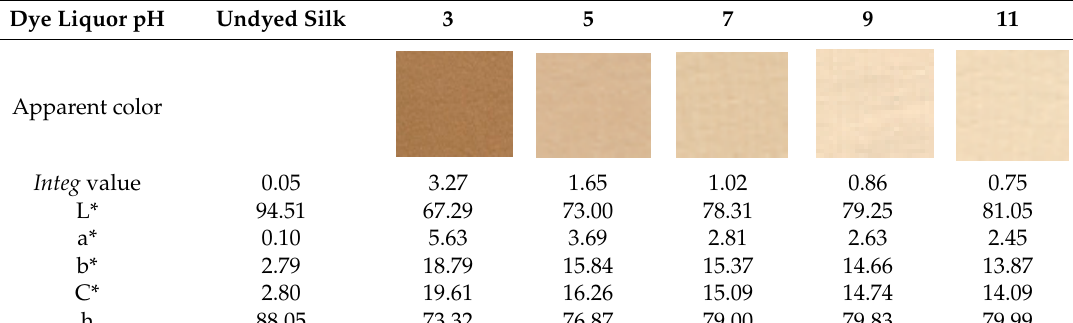
Figure 5. Effect of pH value on Integ value of dyed silk fabrics. Table 2. The color parameters of dyed silk fabrics based on laccase-catalyzed oxidative Table 2. The color parameters of dyed silk fabrics based on laccase-catalyzed oxidative polymerization Table 2. The color parameters of dyed silk fabrics based on laccase-catalyzed oxidative Table 2. The color parameters of dyed silk fabrics based on laccase-catalyzed oxidative Table 2. The color parameters of dyed silk fabrics based on laccase-catalyzed oxidative Table 2. The color parameters of dyed silk fabrics based on laccase-catalyzed oxidative Table 2. The color parameters of dyed silk fabrics based on laccase-catalyzed oxidative Table 2. The color parameters of dyed silk fabrics based on laccase-catalyzed oxidative Table 2. The color parameters of dyed silk fabrics based on laccase-catalyzed oxidative Table 2. The color parameters of dyed silk fabrics based on laccase-catalyzed oxidative Table 2. The color parameters of dyed silk fabrics based on laccase-catalyzed oxidative polymerization for tea polyphenols. Table 2. The color parameters of dyed silk fabrics based on laccase-catalyzed oxidative Table 2. The color parameters of dyed silk fabrics based on laccase-catalyzed oxidative for tea polyphenols. Table 1. The color parameters of dyed silk fabrics with tea polyphenols. polymerization for tea polyphenols. polymerization for tea polyphenols. polymerization for tea polyphenols. polymerization for tea polymerization for tea polyphenols. polymerization for tea polyphenols. polymerization for tea polyphenols. polymerization for tea polyphenols. polymerization for tea polyphenols. polymerization for tea polyphenols. polymerization for tea polyphenols.